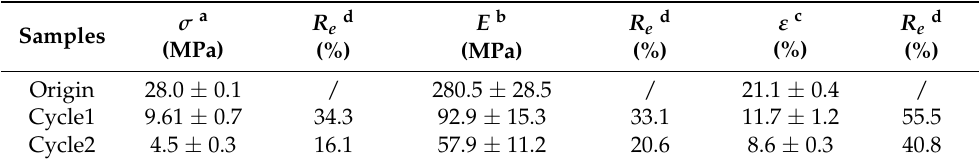
Table 7. Mechanical properties of the original and recycled materials.